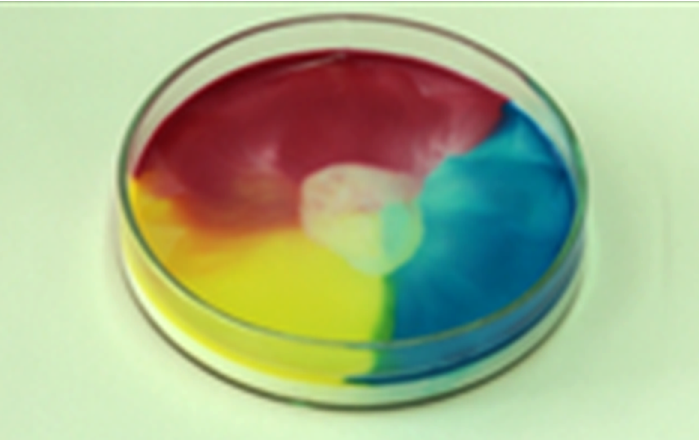
Figure 1. Rotating movements of the individual colours